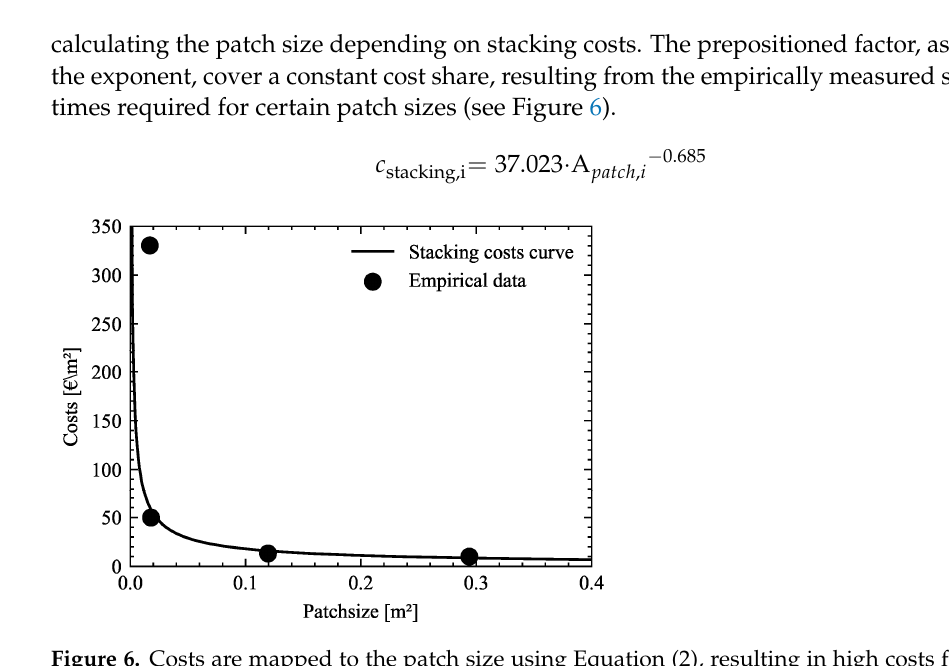
Figure 6. Costs are mapped to the patch size using Equation (2), resulting in high costs for small patches and low costs for large patches.